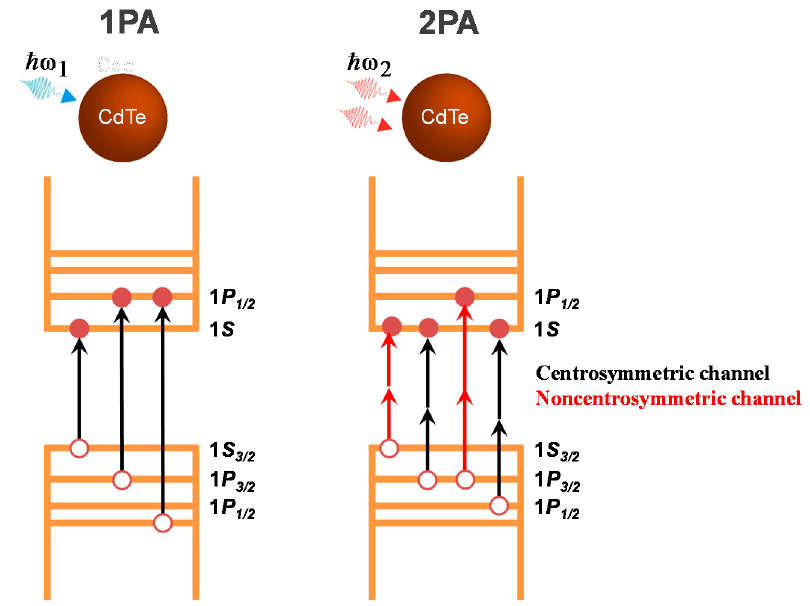
Figure 1. Energy diagram for the lowest energy 1PA- and 2PA-allowed transitions for quantum dots (QDs).